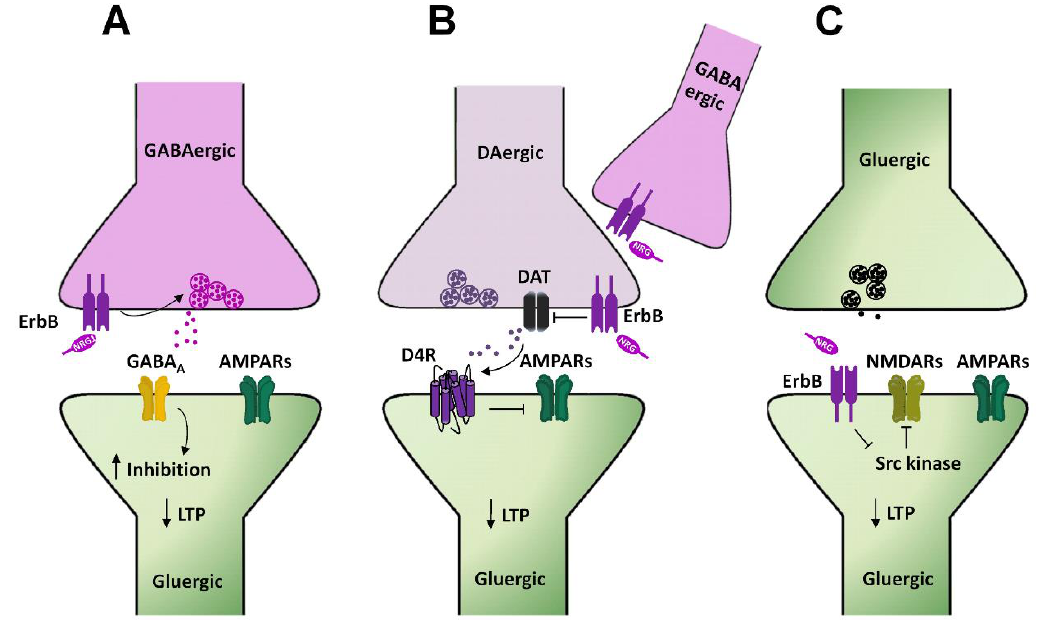
Figure 3. NRGs / ErbB-dependent regulation of LTP in the hippocampal CA1 area. ( A – C ) Diagrams illustrating the cellular mechanisms underlying NRGs / ErbB-dependent impairment of LTP at hippocampal CA3–CA1 synapses. ( A ) NRG1-dependent activation of ErbB4 in GABAergic interneurons, by triggering GABA release, fosters the activation of GABA A receptors expressed in CA1 pyramidal cells, thus reducing neuronal excitability and dampening LTP induction. ( B ) NRG1-induced ErbB4 activation on DAergic terminals inhibits DAT activity, thus increasing DA extracellular levels. The consequent activation of D4 receptors localized on CA1 pyramidal neurons impairs LTP induction / expression, via internalization of AMPARs. ( C ) NRG1-dependent ErbB4 activation in CA1 pyramidal neurons inhibits Src kinase and consequently NMDAR activity, thus reducing LTP expression.